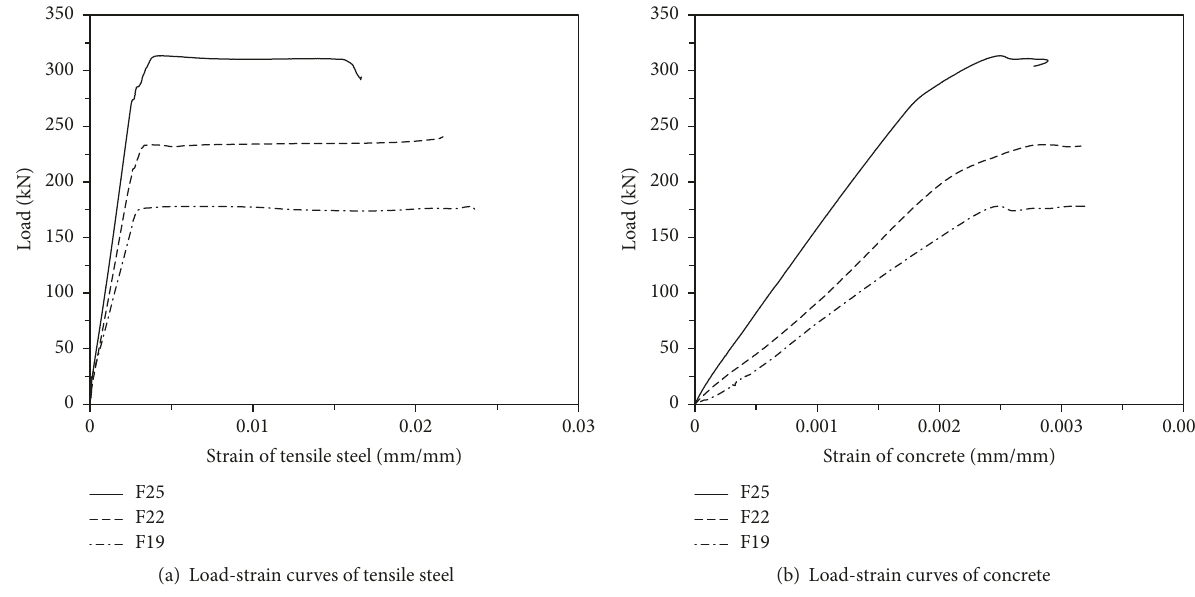
Figure 5: Load-strain curves of flexural test specimens according to steel ratio.